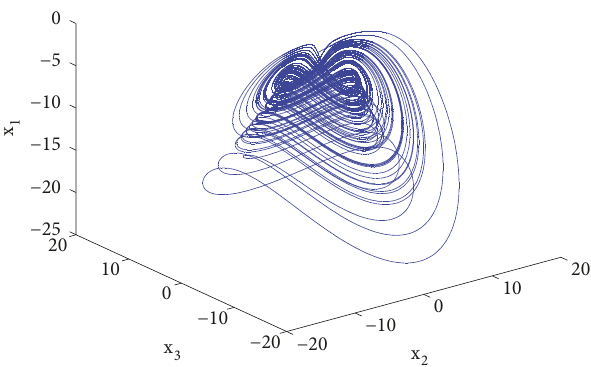
Figure 1: The chaos attractor of system (35) with (𝑥 1 (0),𝑥 2 (0),𝑥 3 (0)) = (−3,1.5, 2) .